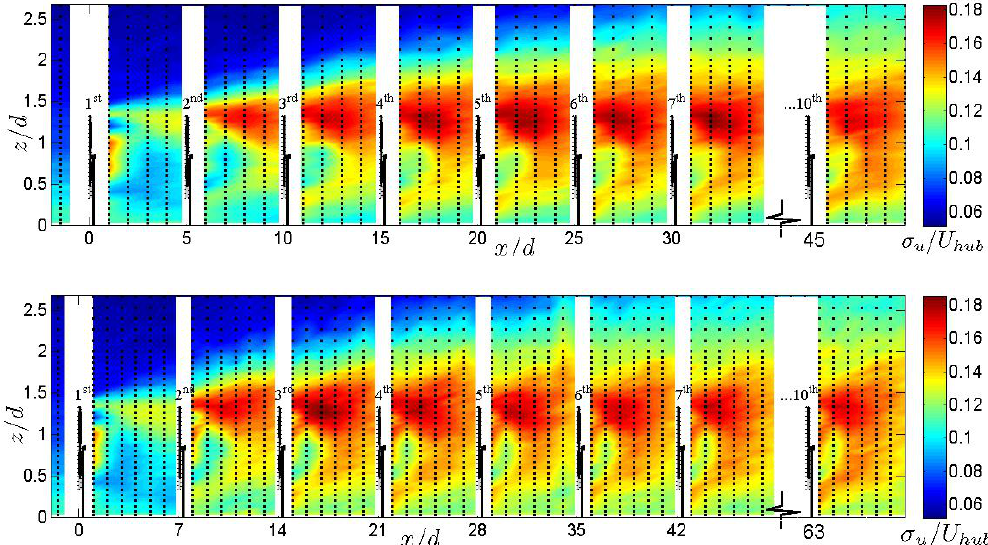
Figure 6. Turbulence intensity distribution around the wind farm. S ( bottom ). Dots indicate measurement